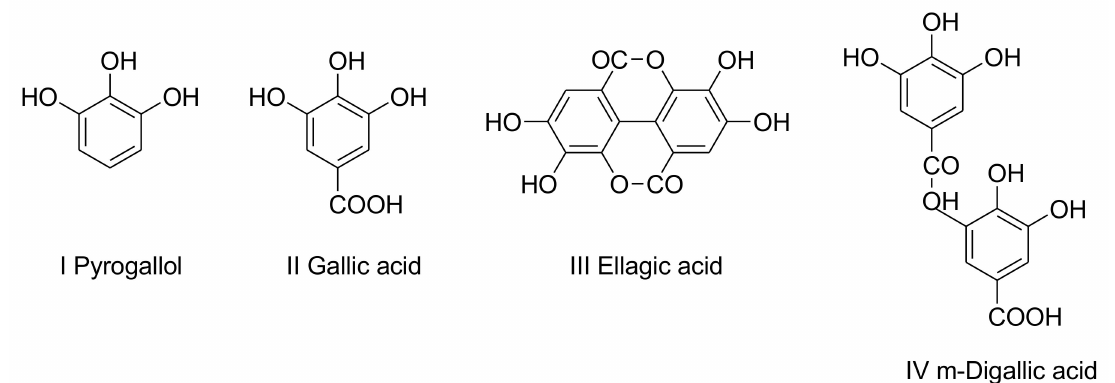
Figure 7. Simple phenol structures in tannin